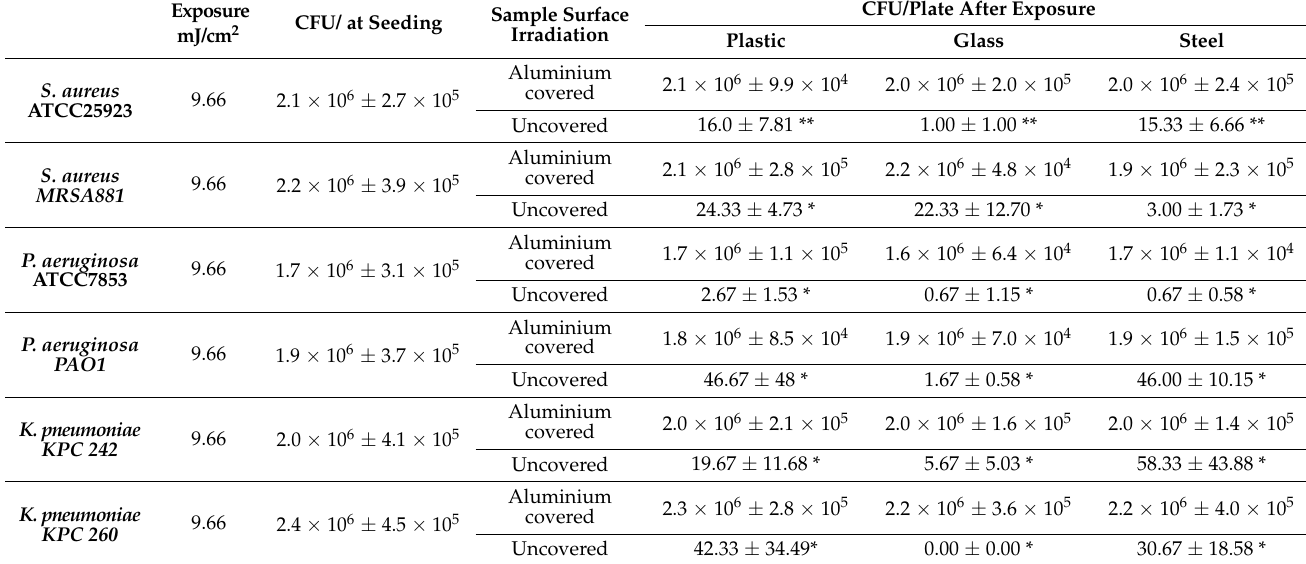
Table 3. Effect of UV-C irradiation on different